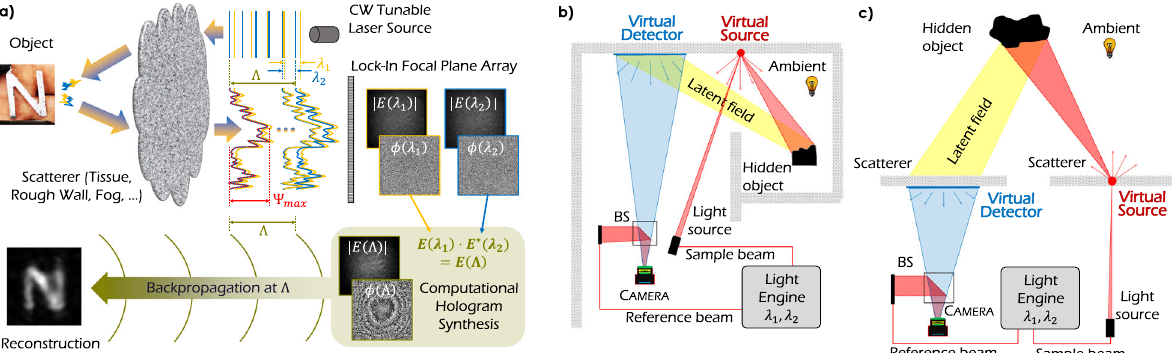
Fig. 1 Schematics of SWH for NLoS imaging around corners and NLoS imaging through scattering media. a SWH image formation: A continuous wave (CW) tunable laser illuminates the scene at two slightly different wavelength λ 1 and λ 2 . Each fi eld E ( λ 1 ), E ( λ 2 ) is subject to multiple scattering processes in or at the scatterer (which could be wall, tissue, fog,...) and the rough object surface. The introduced maximal pathlength variation Ψ max leads to a complete randomization of E ( λ 1 ), E ( λ 2 ) (with respective phasemaps ϕ ( λ 1 ), ϕ ( λ 2 )) when arriving at the detector. However, computational mixing of the speckled fi elds E ( λ ⋅ E * ( λ = E ( Λ ), yields a complex-valued hologram of the object at a Synthetic Wavelength (SWL) Λ ¼ λ 1 (cid:3) λ 2 1 ) 2 ) backpropagating E ( Λ ) with the SWL Λ . b and c Schematic setups for NLoS imaging around corners ( b ) and NLoS imaging through scatterers ( c ) with the SWH principle: The sample beam illuminates a spot on the wall/scatterer (the Virtual Source VS), which scatters light towards the obscured object. A small fraction of the light incident on the object is scattered back to the wall/scatterer where it hits the Virtual Detector (VD). The VD is imaged by the camera, meaning that the synthetic hologram is captured at the VD surface. Details and internals of the light engine are speci fi ed in the Supplementary Fig.